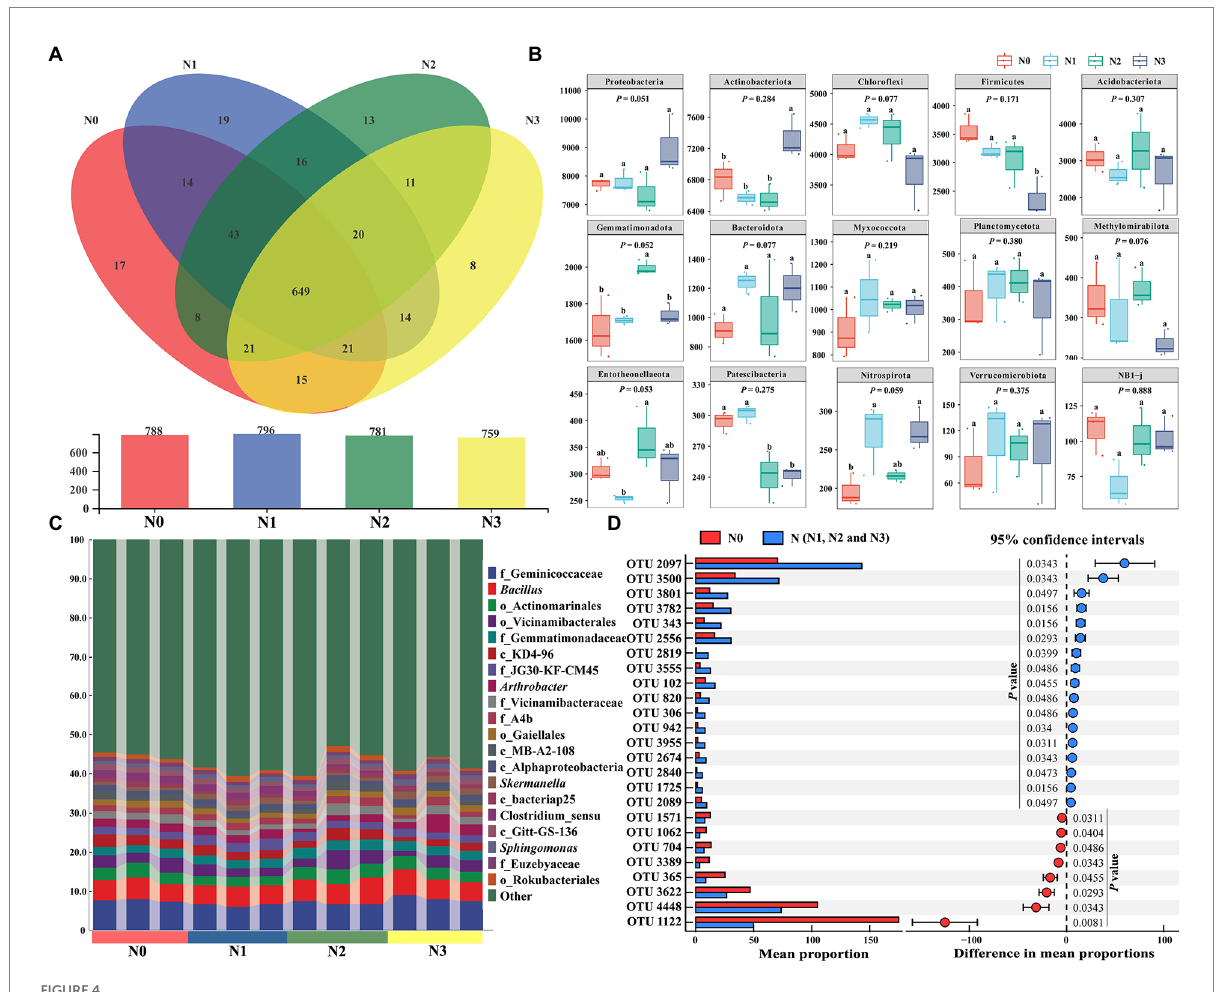
FIGURE 4 N-induced changes in bacterial community structure and